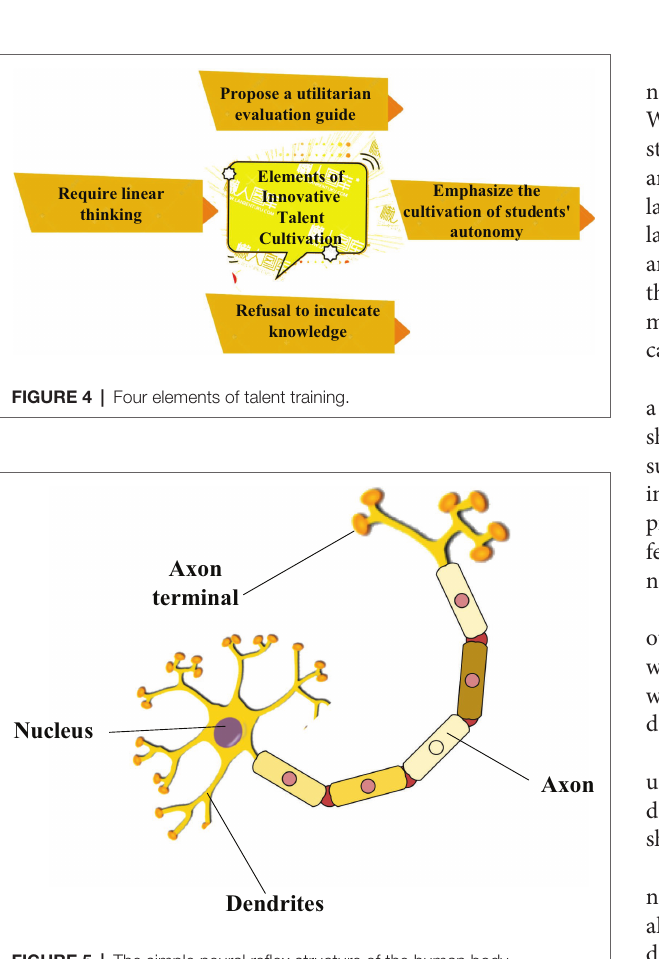
of the human body is represented by a scientific block diagram, which is the most basic single-layer neural network structure in the neural network (Indolia et al., 2018). Figure 6 is a single-layer simulation diagram of a single neuron unit. The single-layer simulation of a single neuron unit transmits the data information from the input layer to the neuron unit, processes the data through functional operations, and finally outputs the required data.